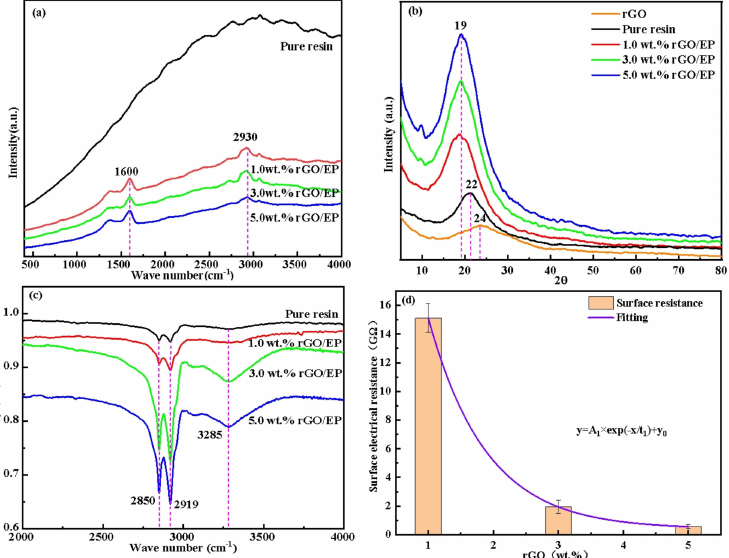
Figure 3. Characterization of rGO/EP coatings: ( a ) Raman, ( b ) XRD, ( c ) FTIR, ( d ) surface electrical